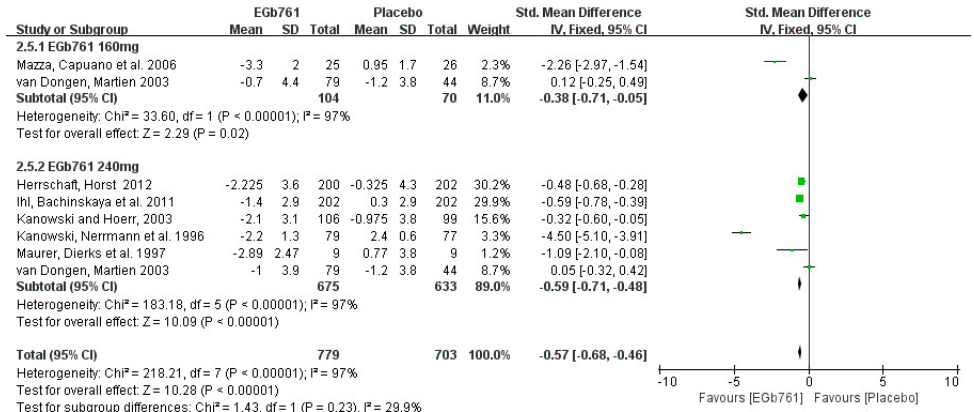
Figure 6. Meta-analysis of all patients in SKT. The square area represents the weight assigned to the study in the meta-analysis. The horizontal line represents the 95% confidence interval.